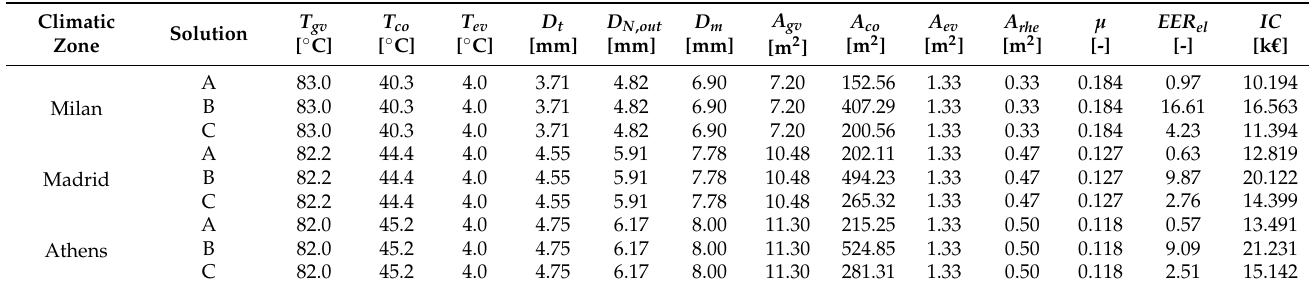
Table 3. Sizing results.